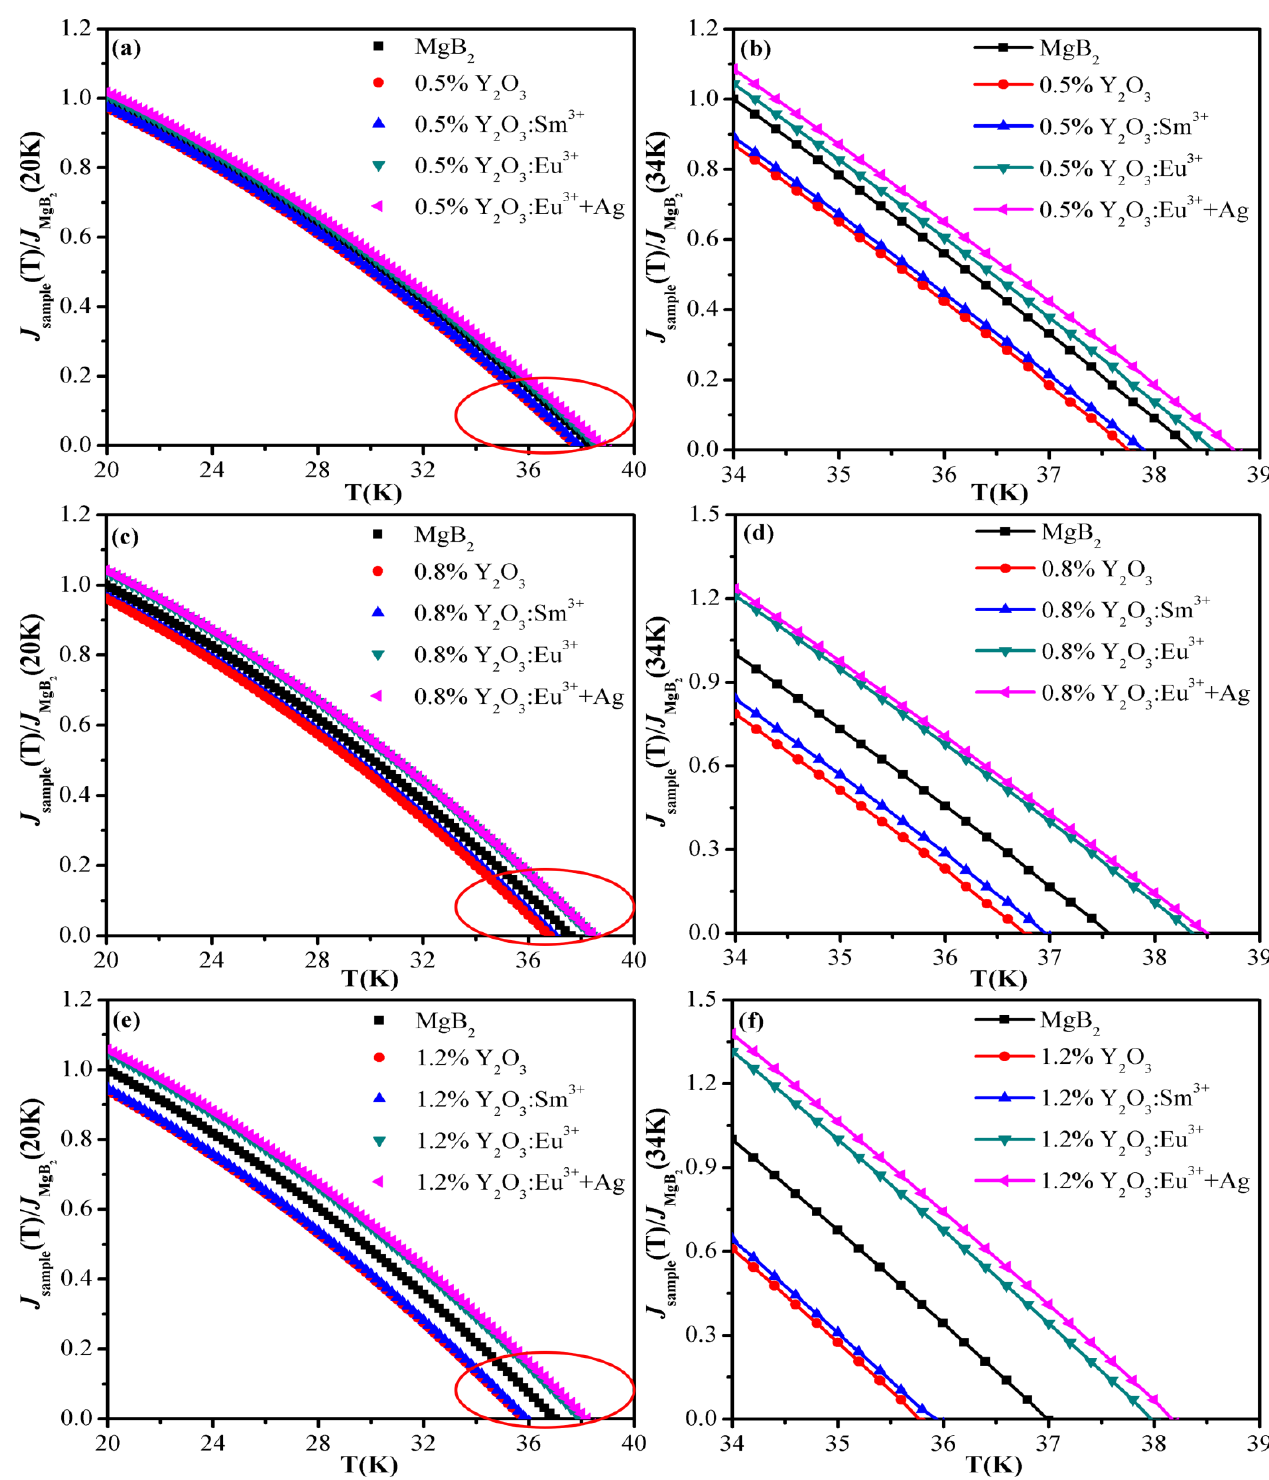
Figure 2. The relationship between J C and temperature of pure MgB 2 and doping MgB 2 samples. ( a , b ) The relationship between J C and temperature of pure a MgB 2 and a MgB 2 doped with 0.5 wt% Y 2 O 3 :Sm 3+ , Y 2 O 3 , Y 2 O 3 :Eu 3+ , and Y 2 O 3 :Eu 3+ +Ag. ( c , d ) The relationship between J C and temperature of pure b MgB 2 and b MgB 2 doped with 0.8 wt% Y 2 O 3 :Sm 3+ , Y 2 O 3 , Y 2 O 3 :Eu 3+ , and Y 2 O 3 :Eu 3+ +Ag. ( e , f ) The relationship between J C and temperature of pure c MgB 2 and c MgB 2 doped with 1.2 wt% Y 2 O 3 :Sm 3+ , Y 2 O 3 , Y 2 O 3 :Eu 3+ , and Y 2 O 3 :Eu 3+ +Ag. ( b , d , f ) are partial enlarged images.